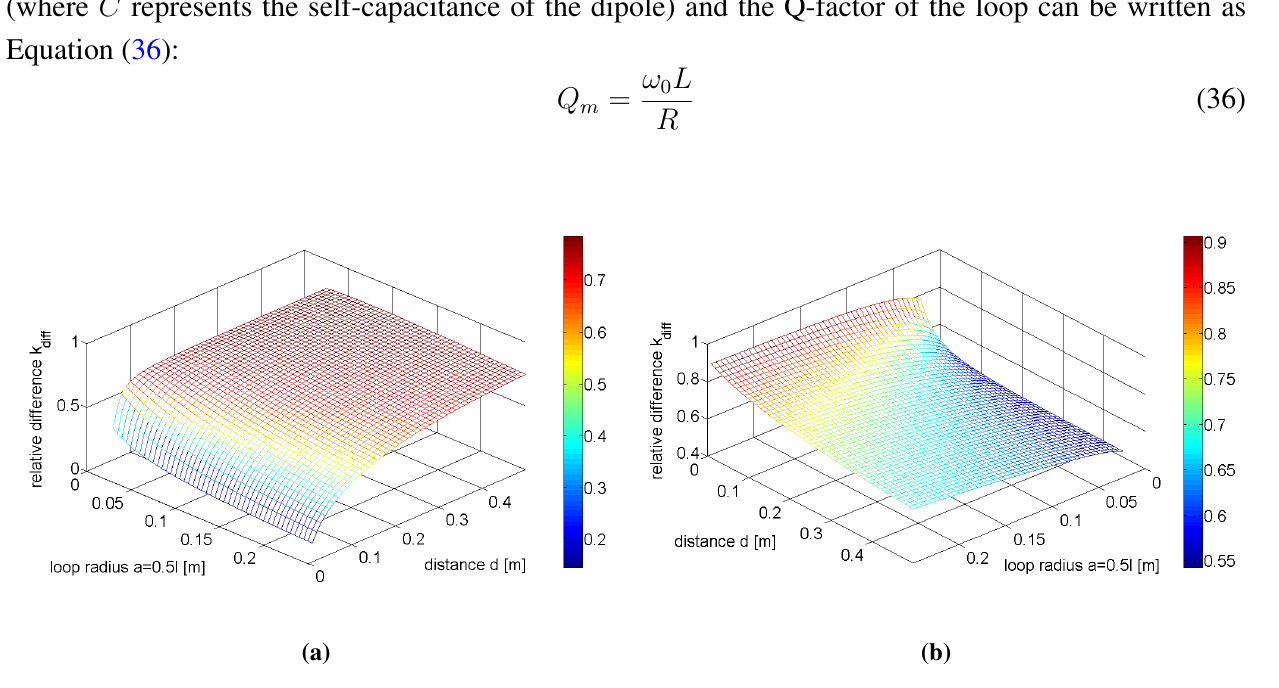
Figure 8. Relative difference k between the coupling coefficients of the loops and dipoles diff for (a) the parallel dipole and coaxial loop configurations and (b) the coaxial dipole and parallel loop